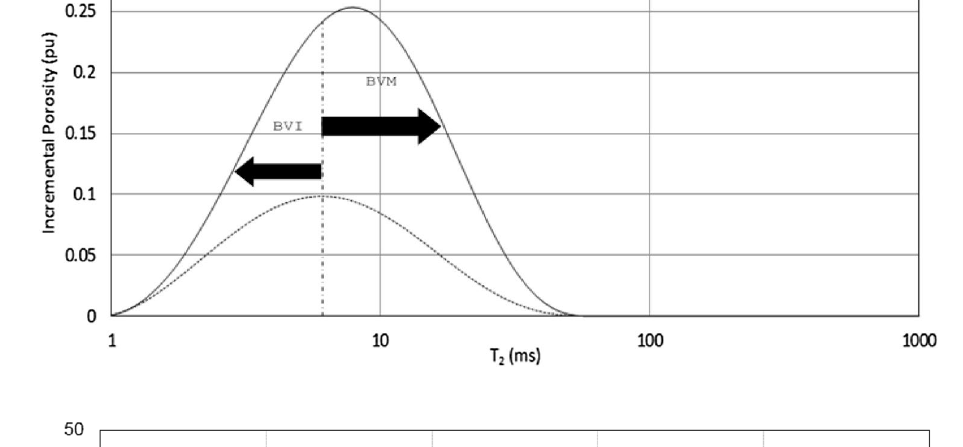
Fig. 4 Determination of BVM and BVI using T 2c in T 2 distri- bution curve (sample 33)